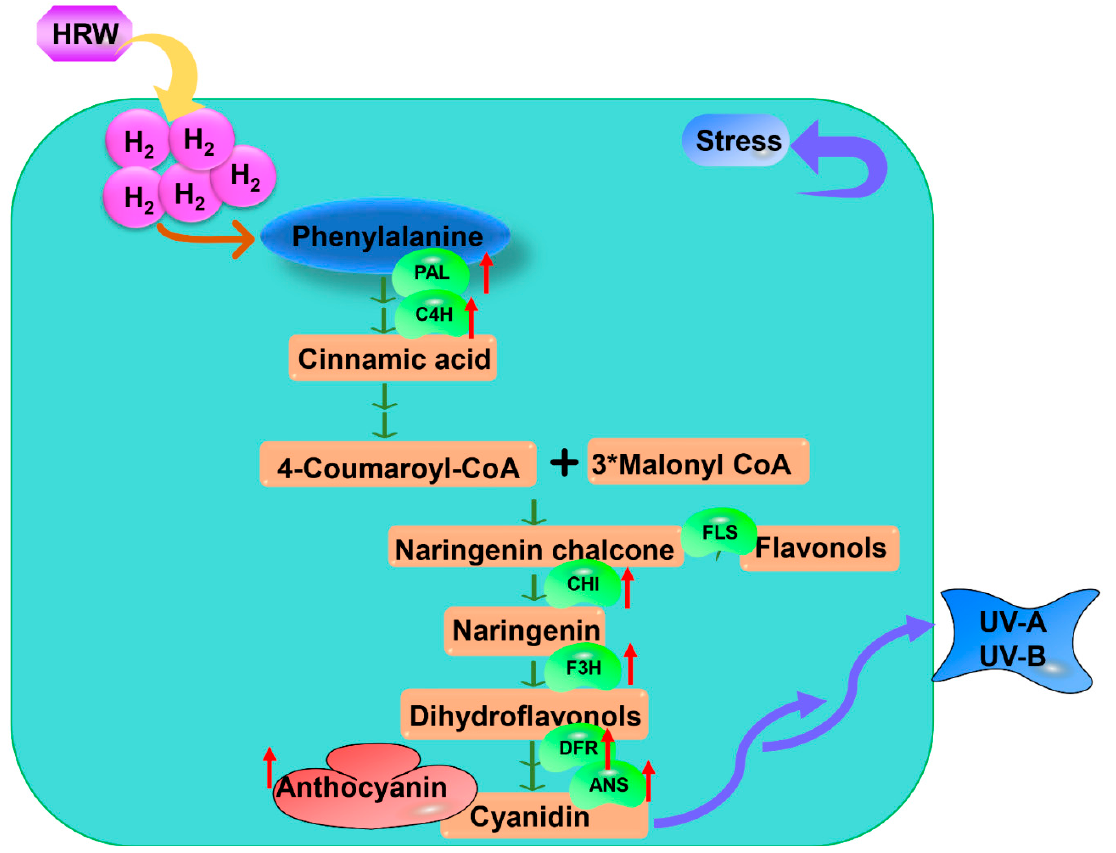
Figure 3. The mode of H 2 -mediated flavonoid pathway under abiotic stress. H 2 -mediated phenylpropanoid pathway promotes anthocyanin biosynthesis under abiotic stress. Some enzymes up-regulated by H 2 are involved in this process, including PAL, C4H, FLS, CHI, F3H, DFR, and ANS. HRW, hydrogen-rich water; H 2 , Hydrogen gas; PAL, phenylalanine ammonia-lyase; C4H, cinnamic acid 4-hydroxylase; FLS, Flavonol synthase; CHI, chalcone synthase; F3H, flavanone-3-hydroxylase; DFR, Dihydroflavonol 4 reductase; ANS, anthocyanidin synthase; UV-A, Ultraviolet-A; UV-B,